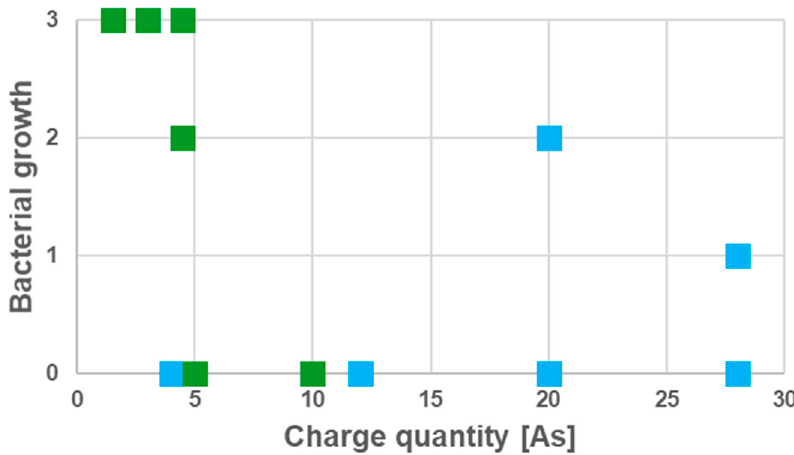
Figure 7. Effect of BDD electrode treatment on Gram-positive bacteria. Elimination of microorganisms depending on the applied charge quantity is shown and currents between 10 and 20 mA were applied in the different experiments (see Figure 6 for evaluation scheme; color coding: B. subtilis : green, S. epidermidis : blue, every square corresponds to an independent set of experiments, i.e., n = 6 for each species).